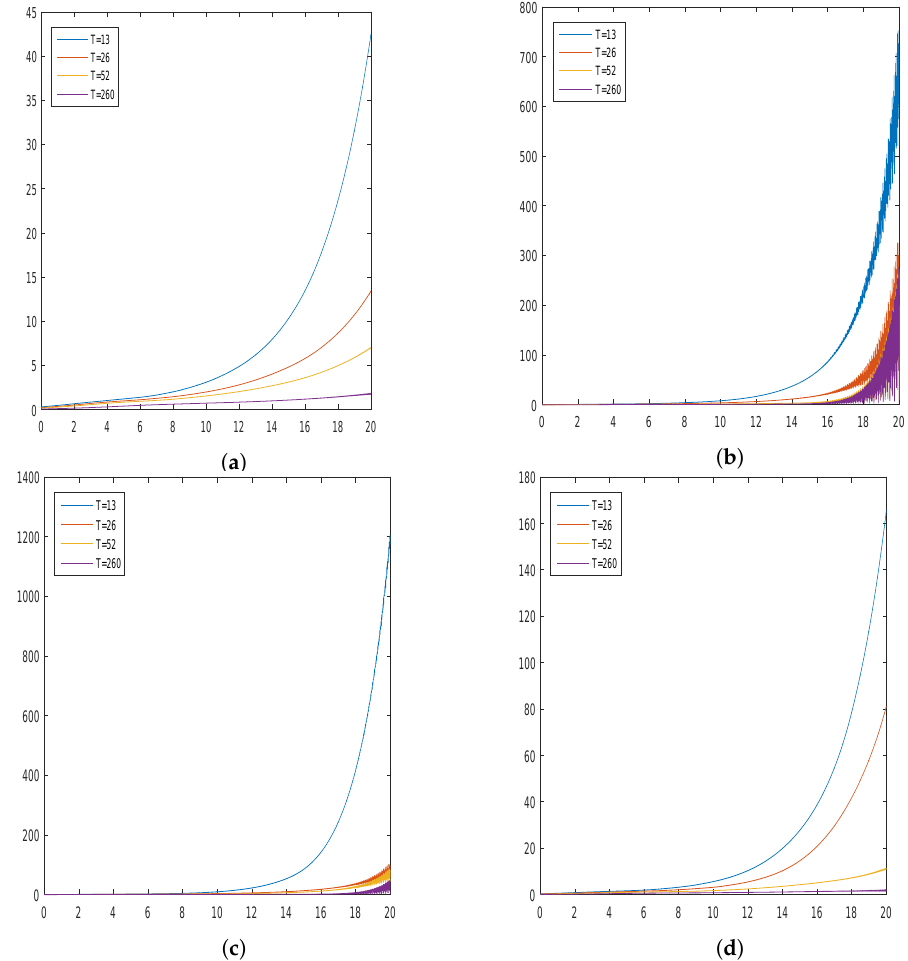
Figure 6. Estimation of the expected discounted deficit at ruin due to a claim for different claim sizes. Mean relative error curves: ( a ) exponential claim sizes; ( b ) Erlang claim sizes; ( c ) combined-exponential claim sizes; and ( d ) mixed-exponential claim